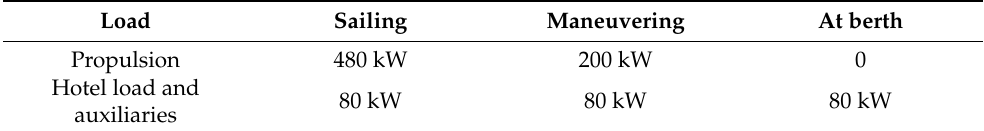
Table 2. Simplified load balance.